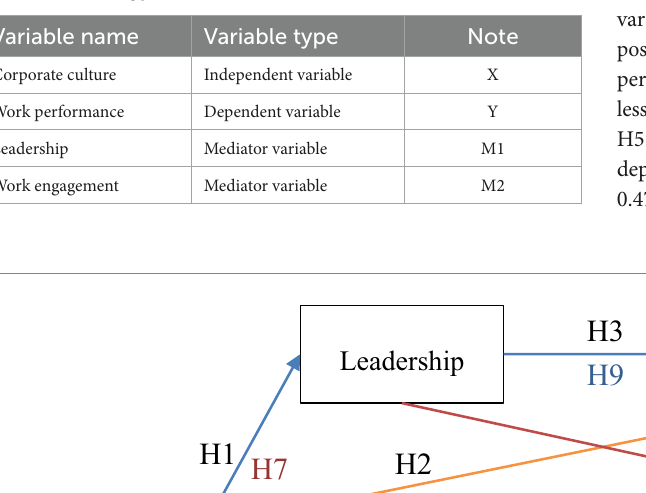
TABLE 2 Variable